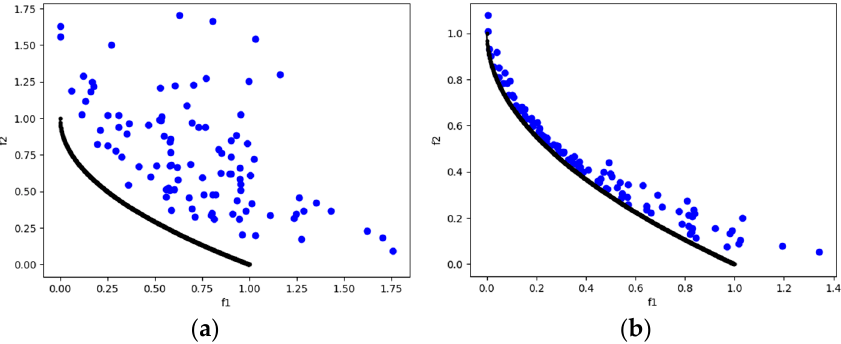
Figure 9. The plots of the approximate PFs with the highest HV value against real PF. ( a ) UF1 approximate PF using MOSA/D-CGO; ( b ) UF1 approximate PF using MOSA/D-DE.